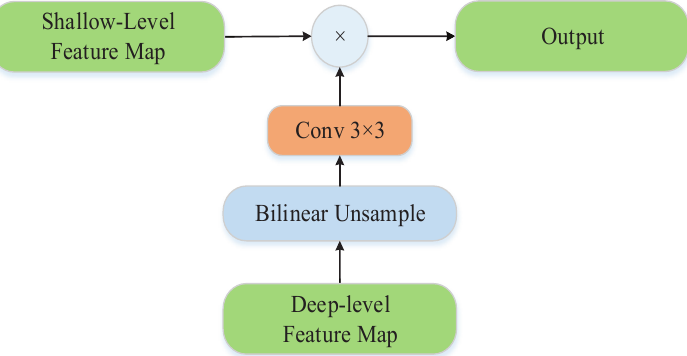
Figure 2. The building block of the semantic transfer block. The ⊗ denotes element-wise